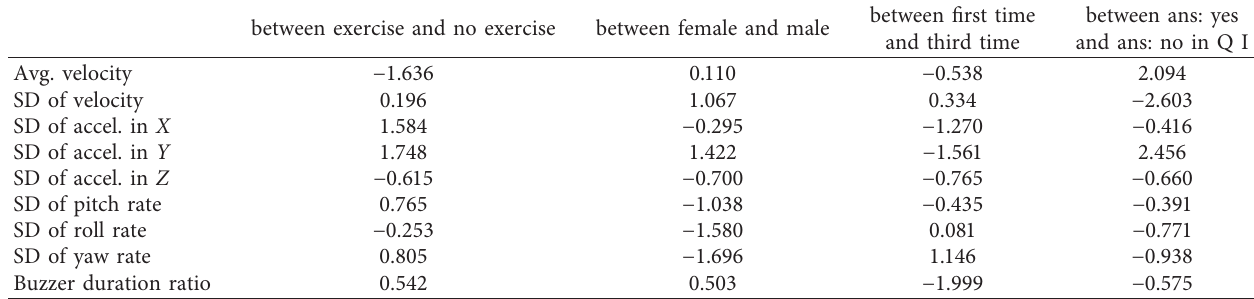
Table 10: t -test results for effects of human factors in scenario 3 (avg.: average, SD: standard deviation, accel.: acceleration, ans: answer, Q: